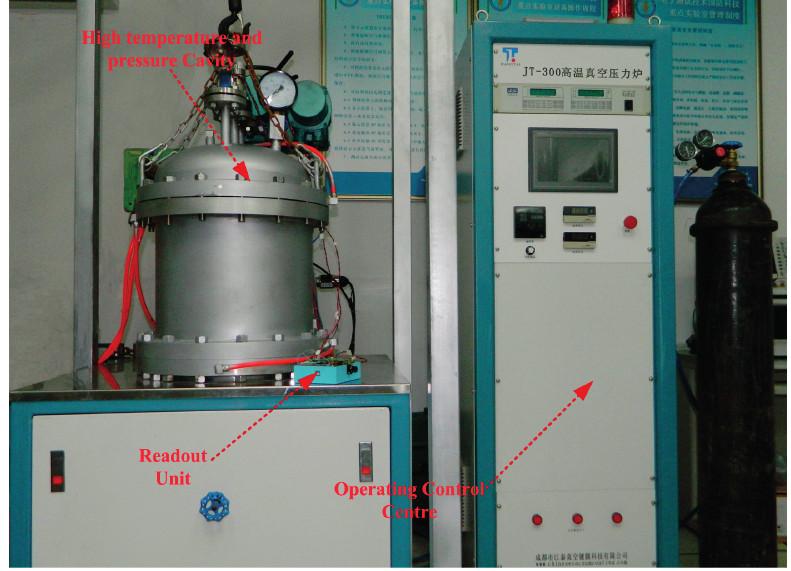
Figure 9. The integrated wireless and passive temperature-pressure test